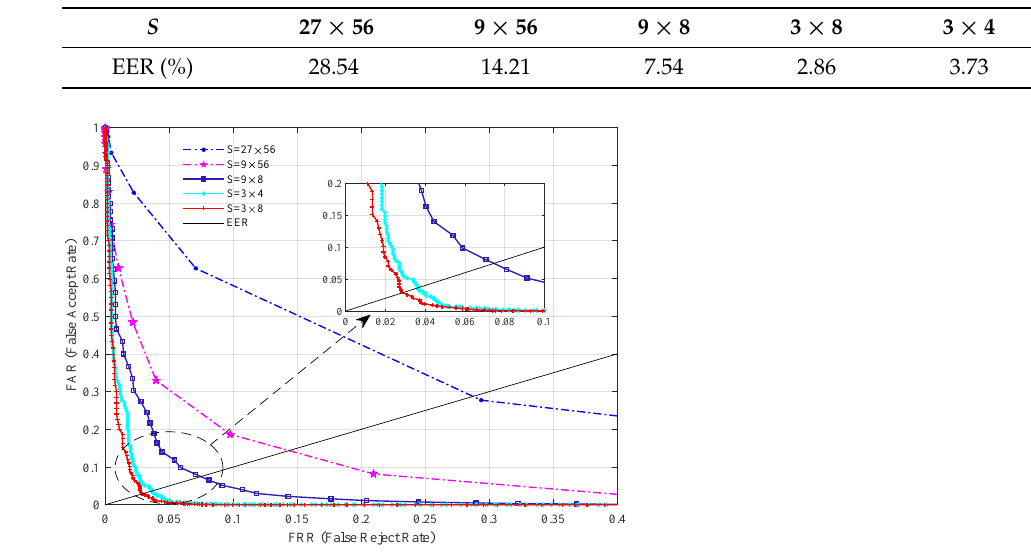
Figure 5. Performance comparison under different block